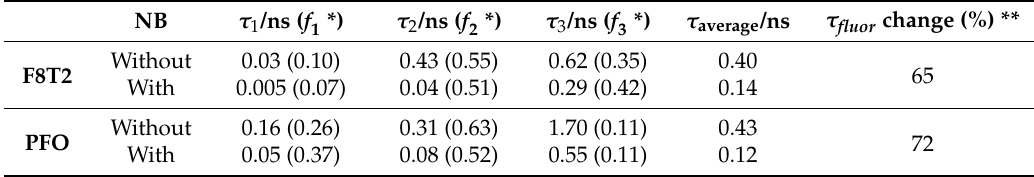
Table 1. Decay times and amplitudes of the PFO and F8T2 in ethyl cellulose thin film without NB vapors and in the presence of NB vapors.